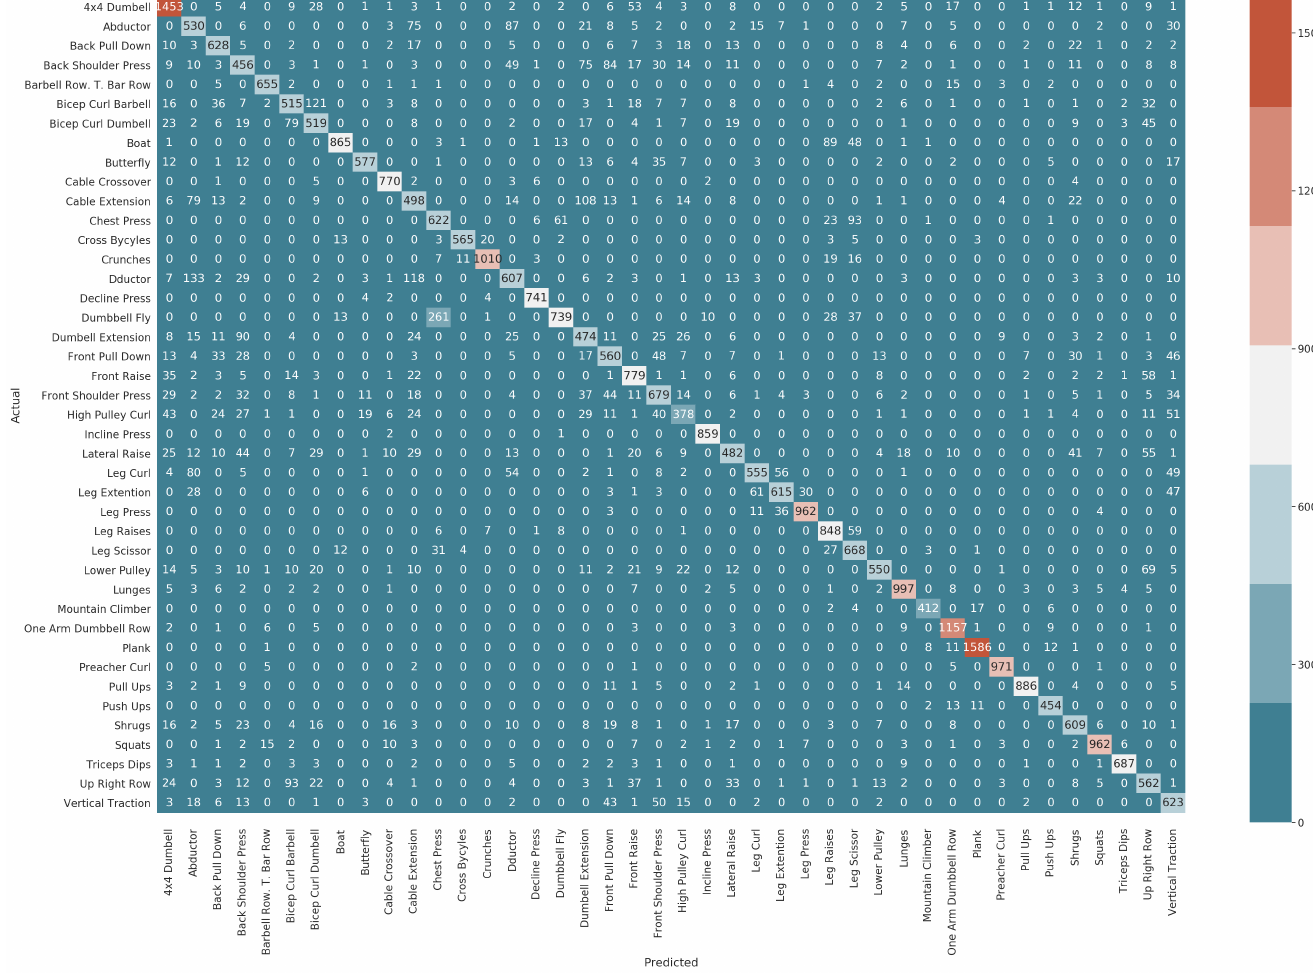
Figure 7. Confusion matrix for one model for 42